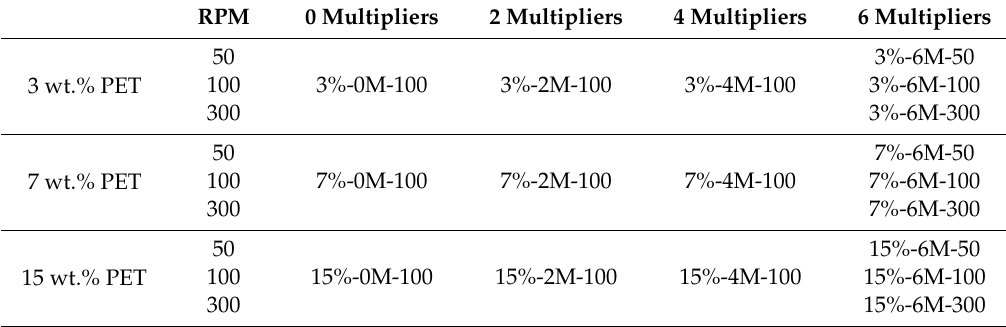
Table 1. Sample codes and processing